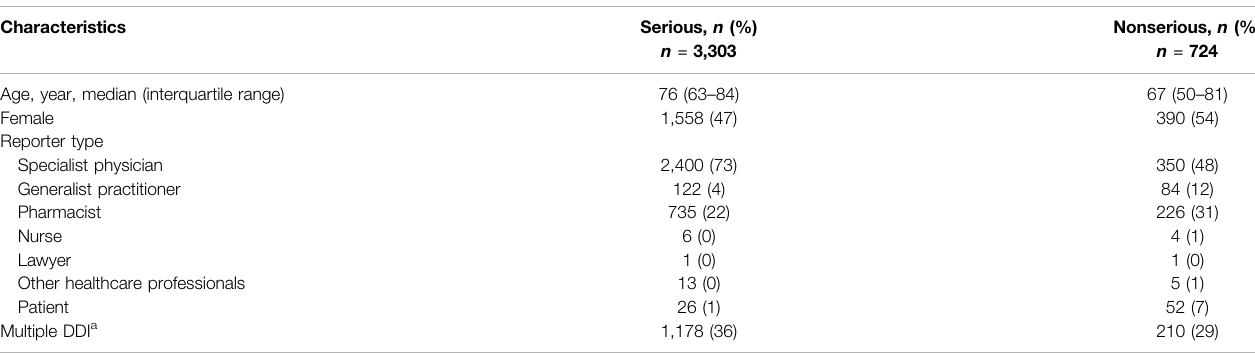
TABLE 2 | General characteristics of serious and nonserious DDI-ADRs. Characteristics